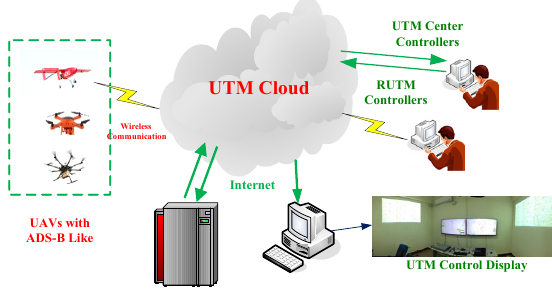
Figure 16. UTM Control Center.